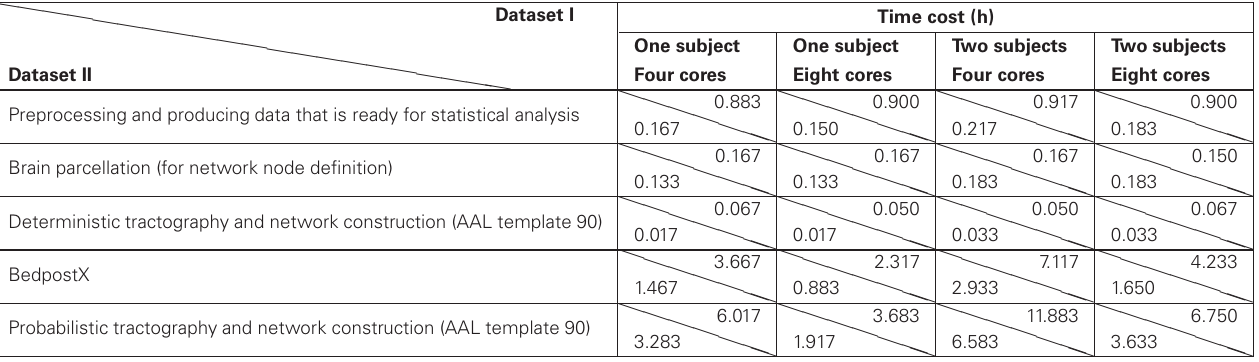
Table 2 | Baseline time cost of pipeline processing on dataset I (64 DWI directions, 4 repetitive acquisitions, resolution: 2 × 2 × 2mm)